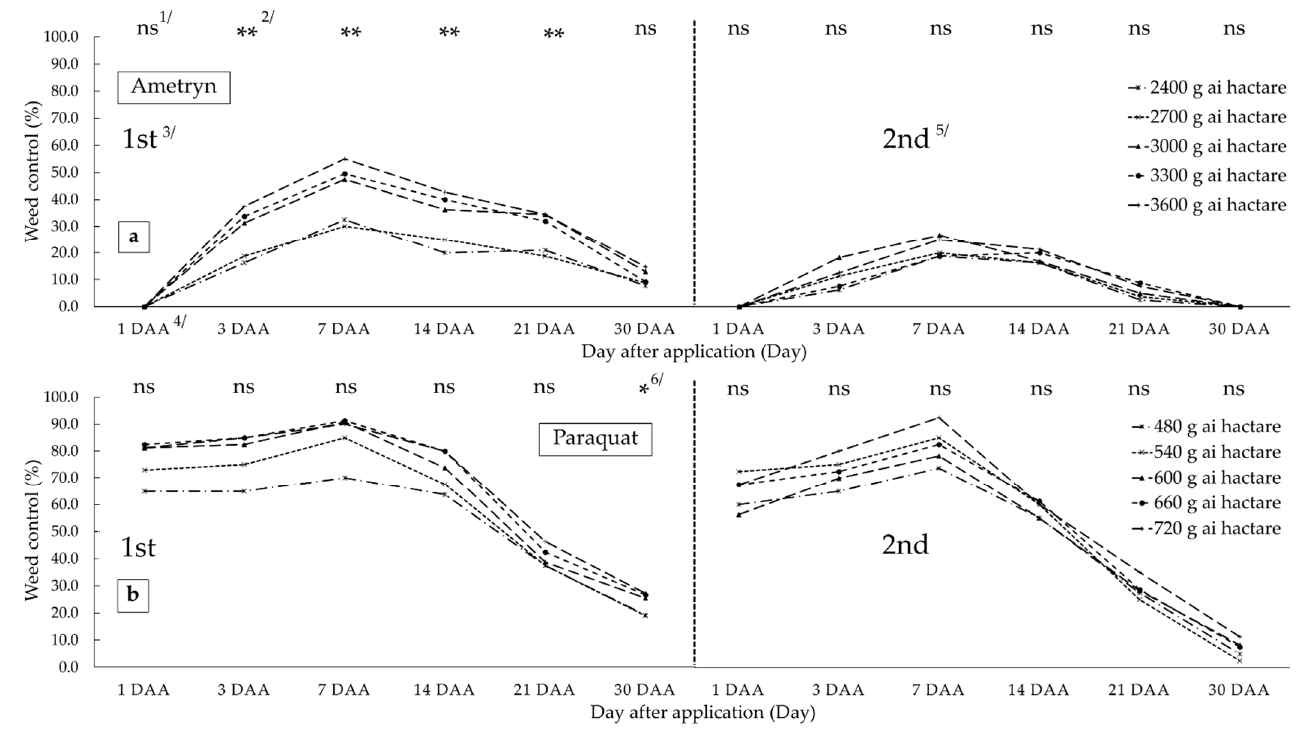
Figure 3. Effects of ametryn and paraquat applications on weed control percentage at various rates in the first and second applications: ( a ) Ametryn applications, ( b ) paraquat applications. 1 / Not significant, 2 / significant at p < 0 . 01, 3 / herbicide application the first time (left), 4 / days after application, 5 / herbicide application the second time (right), and 6 / significant at p < 0 . 05.